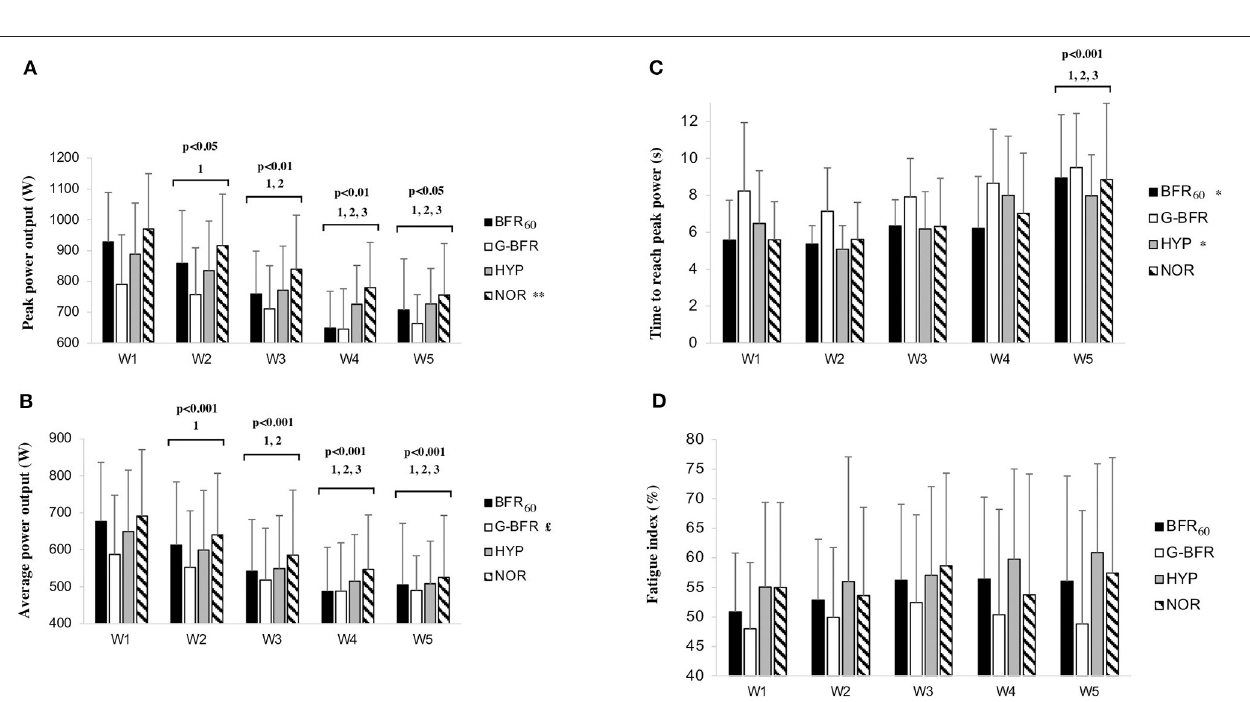
FIGURE 2 | Peak (A) and average (B) power, time to reach peak power (C) , and fatigue index (D) between the different conditions. BFR 60 , blood flow restriction during the two first minutes of recovery; HYP, hypoxia in a chamber at 13.0% FiO 2 ; G-BFR, gravity-induced BFR; NOR, control. Differences between the numbers of the sprint are highlighted by numbers and symbols are used for differences between conditions. 1 Different from sprint number one; 2 different from the second sprint; 3 different from the third sprint; these differences concern the effect of sprint number without distinguishing the exercise modality (n.b., no statistical interaction was found); * p < 0.05 different from G-BFR; ** p < 0.01 different from G-BFR; £ p < 0.05 different from the other conditions.